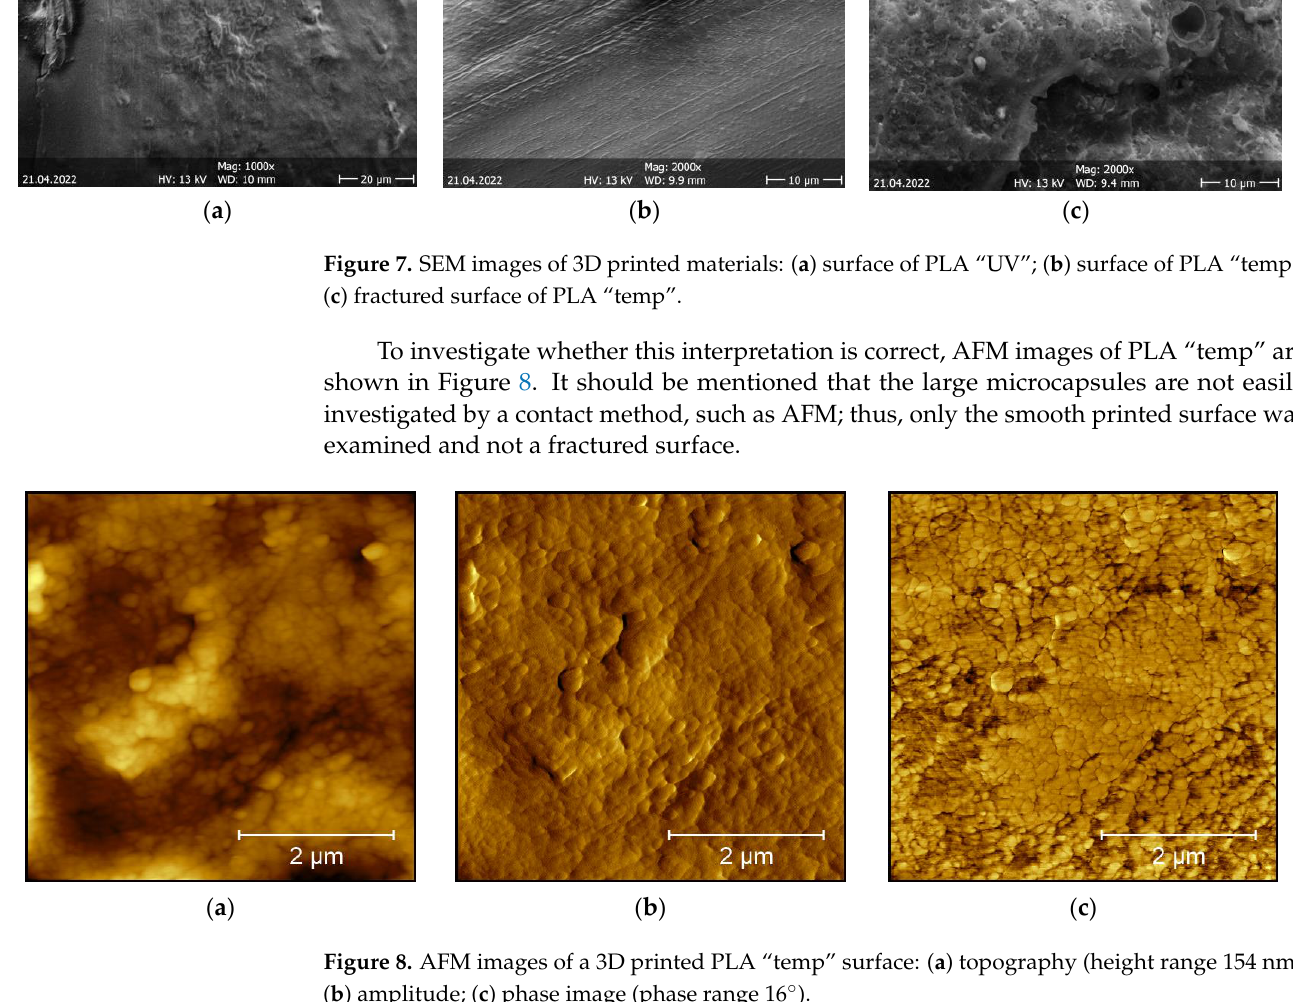
( c ) Figure 9. AFM images of a 3D printed PLA “UV” surface: ( a ) topography (height range 1.2 µm); ( b ) amplitude; ( c ) phase image (phase range 77°).